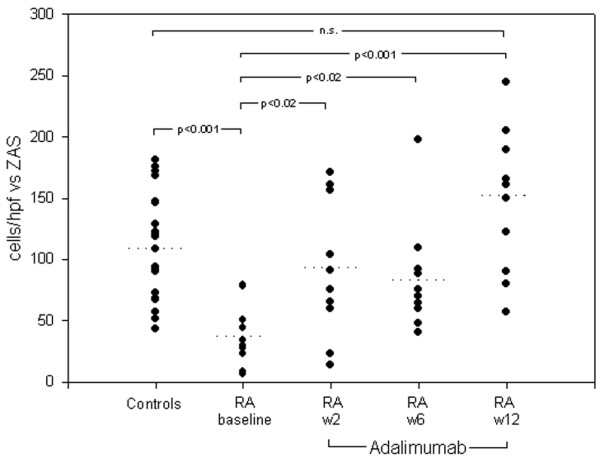
Effect of adalimumab on neutrophil chemotaxis. Peripheral blood neutrophils were purified from 20 controls and 10 patients with rheumatoid arthritis (RA) before (baseline) and during therapy with adalimumab at weeks 2 (w2), 6 (w6) and 12 (w12). Values represent the number of cells migrated × high power field (hpf) using zymosan-activated serum (ZAS) as chemoattractant. The dotted lines indicate the mean values.